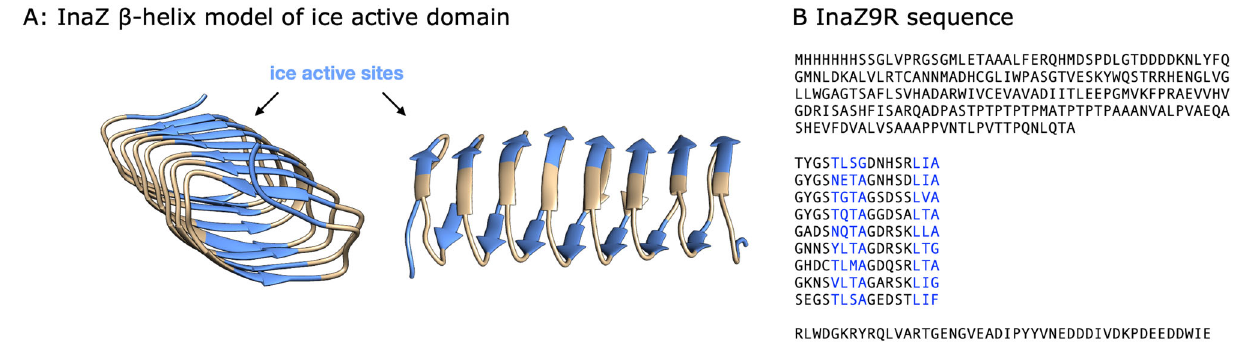
Fig. 1 The InaZ repeat sequence and the model InaZ9R construct. Based on current models, the blue sequences are ice-nucleation active sites. A Repeat structure of the ice-nucleation active protein InaZ without the N- and C-terminal domains. B Sequence of the full InaZ9R construct. It contains an N- terminal tag, the membrane-binding N-terminal domain, the ice-active repeat units, and a C-terminal domain of unknown function 15,17,61,62